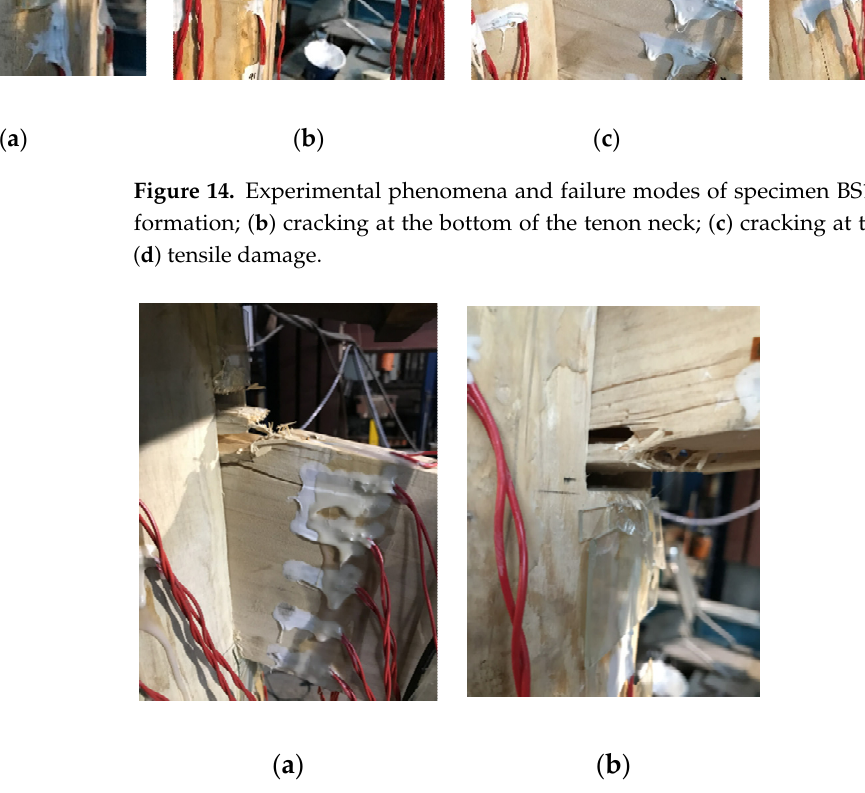
( b ) fracture at the bottom of the tenon neck.